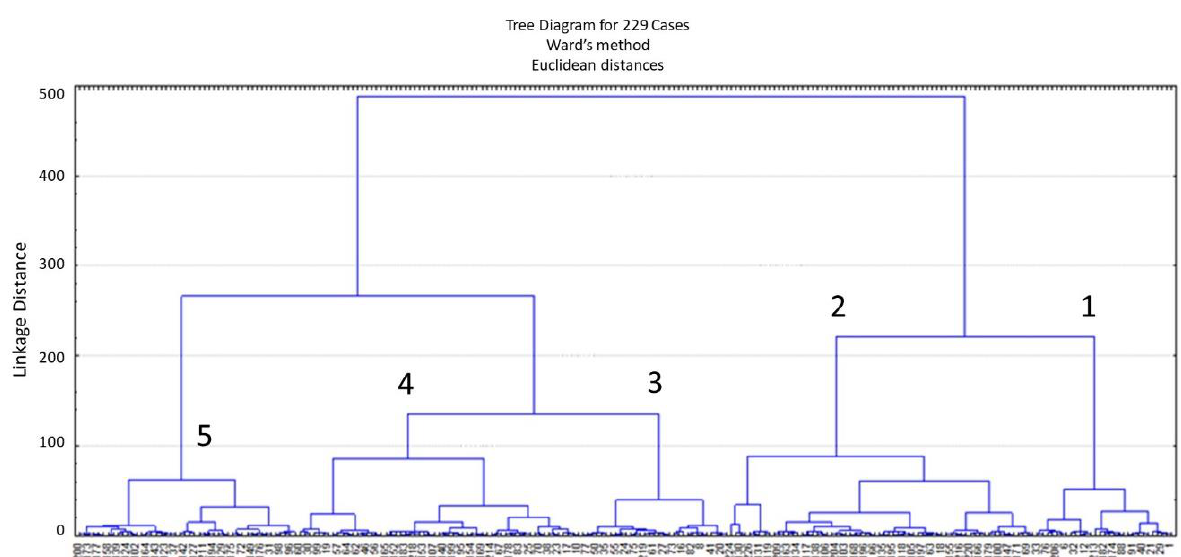
Figure 3. Hierarchical cluster analysis based on the tocol content and composition (see also a more detailed figure in Figure S2).